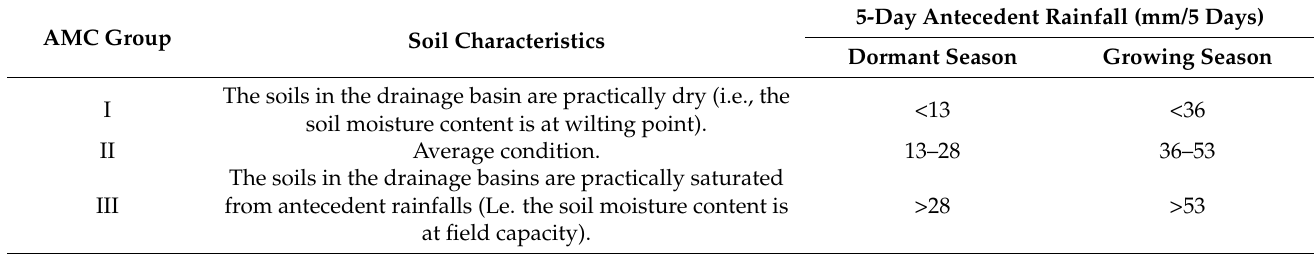
Table 2. Group of Antecedent soil moisture